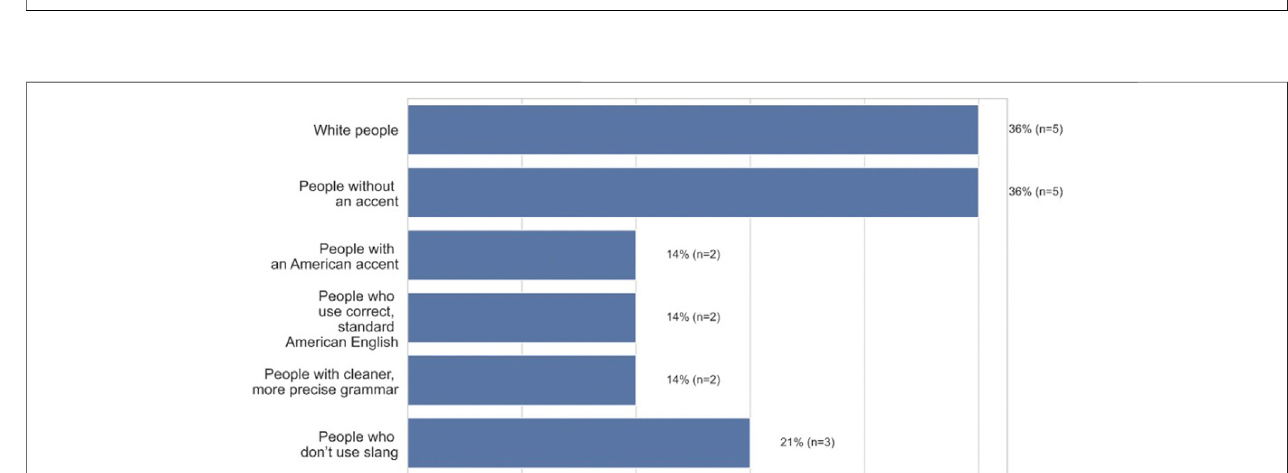
FIGURE 4 | Attribution of errors among African-American participants ( n (cid:1) 30).